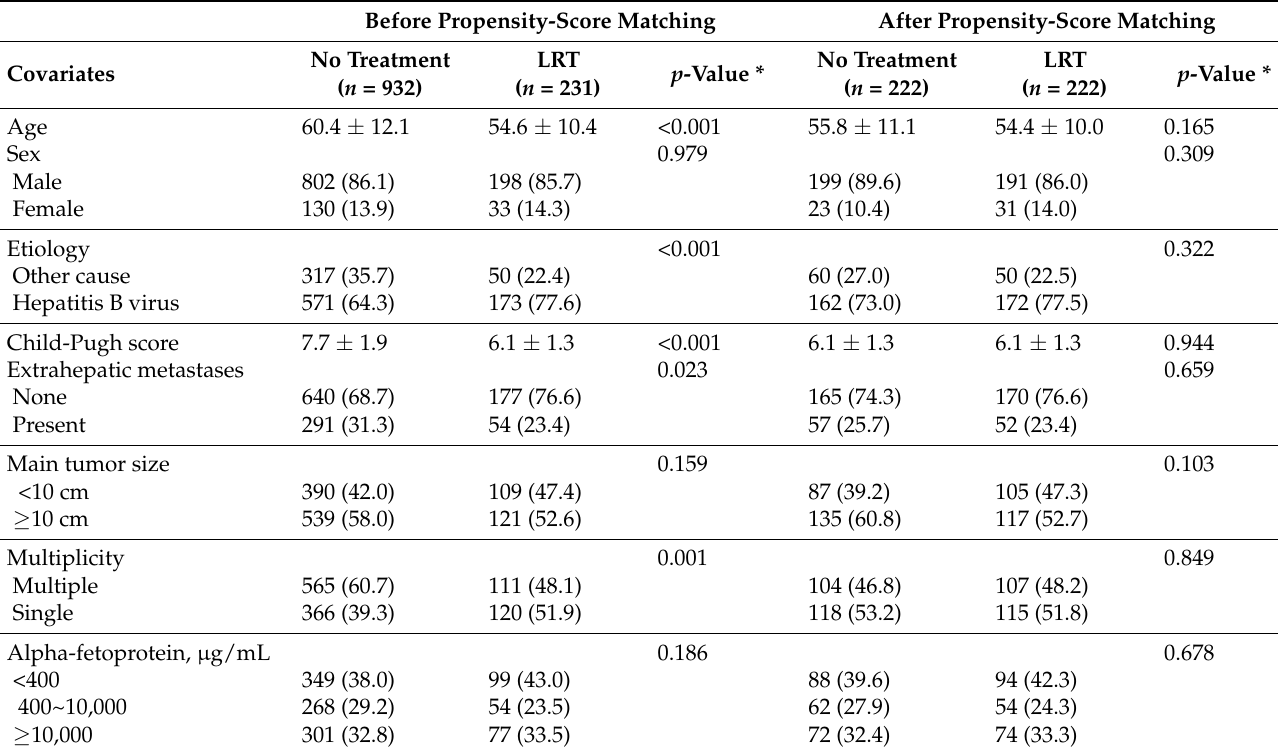
Table 1. Patient characteristics according to propensity-score